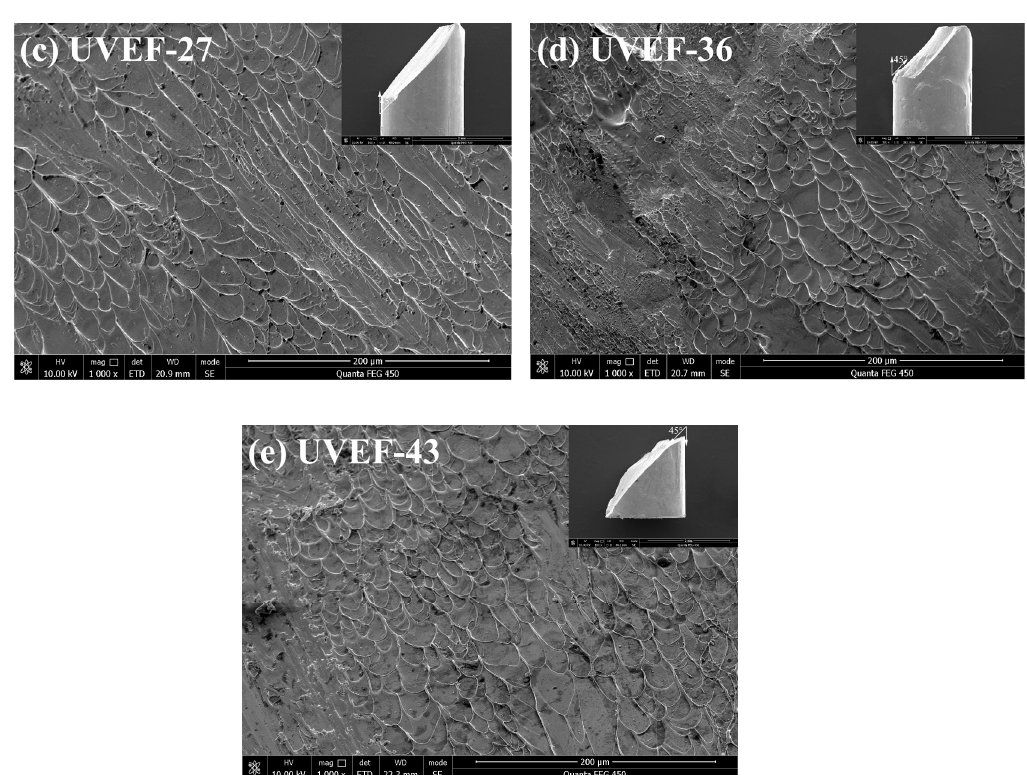
Figure 8. Compressive fracture micromorphology of the as-cast and UVEF-treated samples: ( a ) as-cast; ( b ) UVEF-19; ( c ) UVEF-27; ( d ) UVEF-36; and ( e ) UVEF ‐ 43.